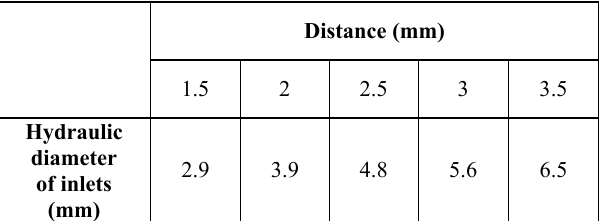
Table 3. Hydraulic diameter for distance.